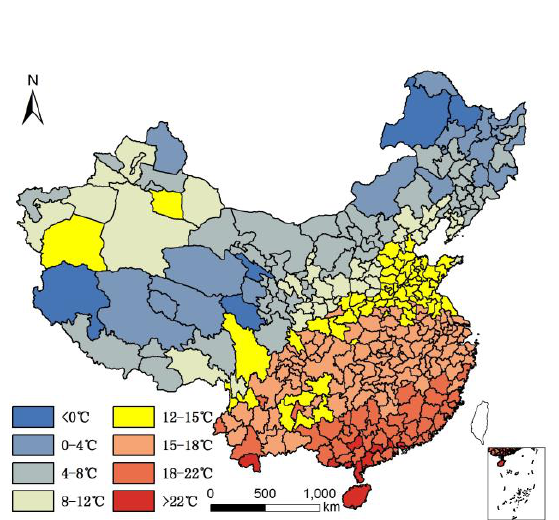
Figure 3. Average temperature in China.